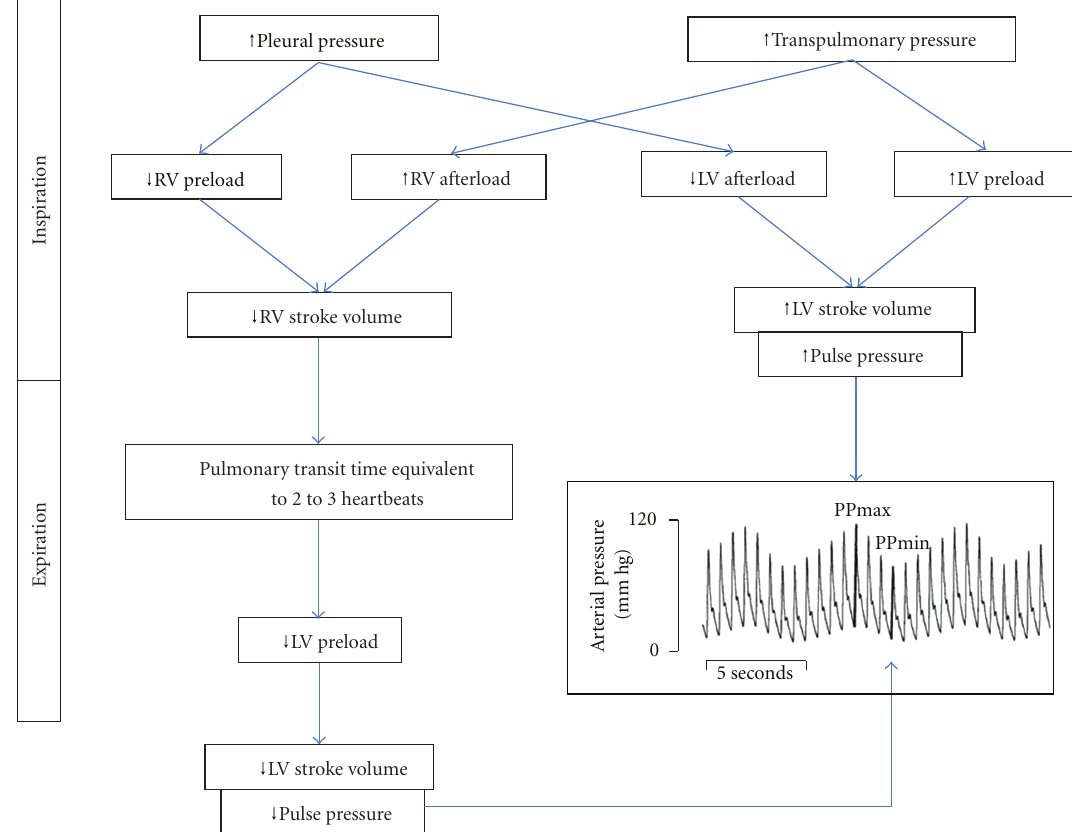
Figure 2: Phenomenon of reverse pulsus paradoxus. RV: right ventricular, LV: left ventricular, PP max : maximum pulse pressure at end- inspiration, PP min : minimum pulse pressure at